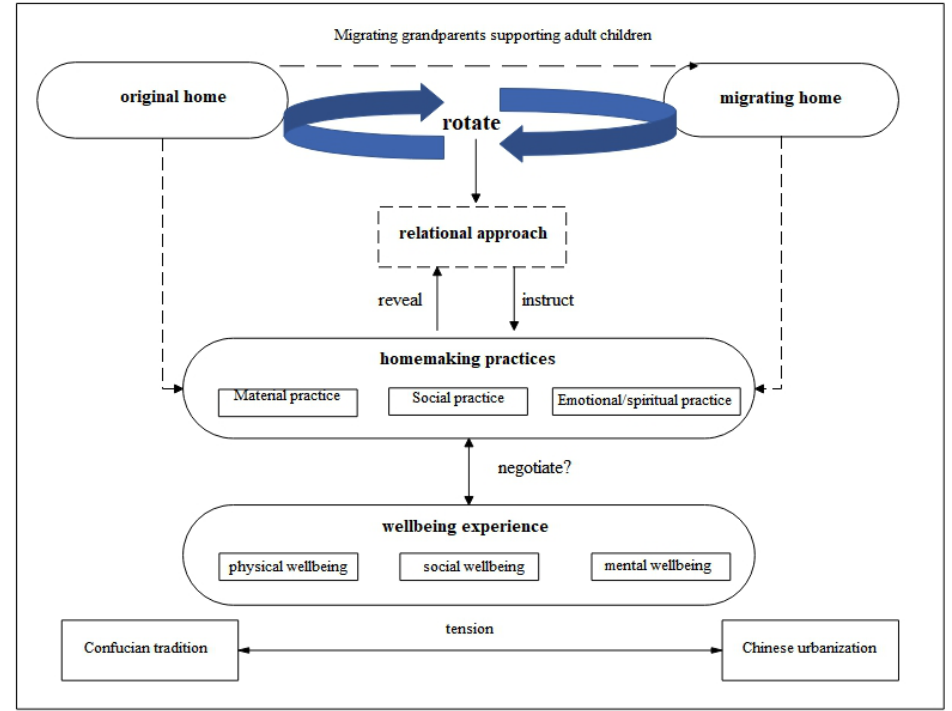
Figure 1. The research